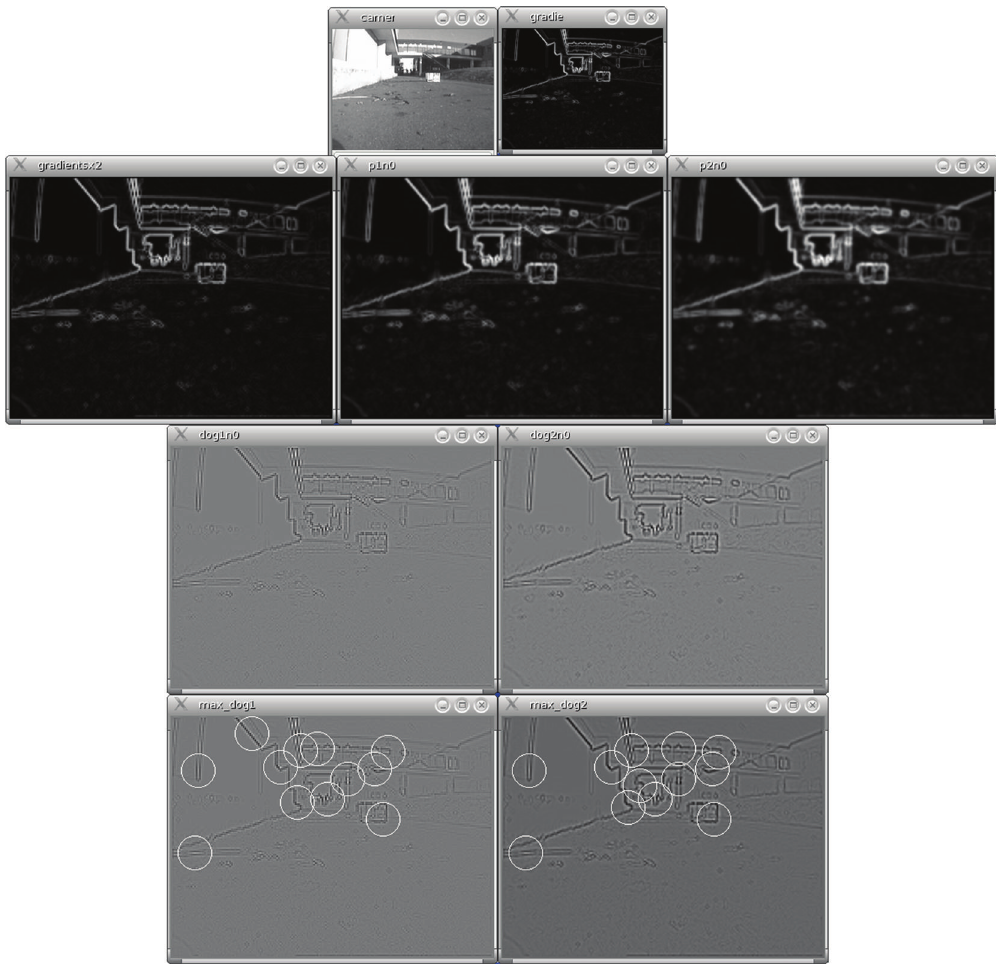
Figure 13: Graphical results of the SystemC functional model simulation of the robotic vision